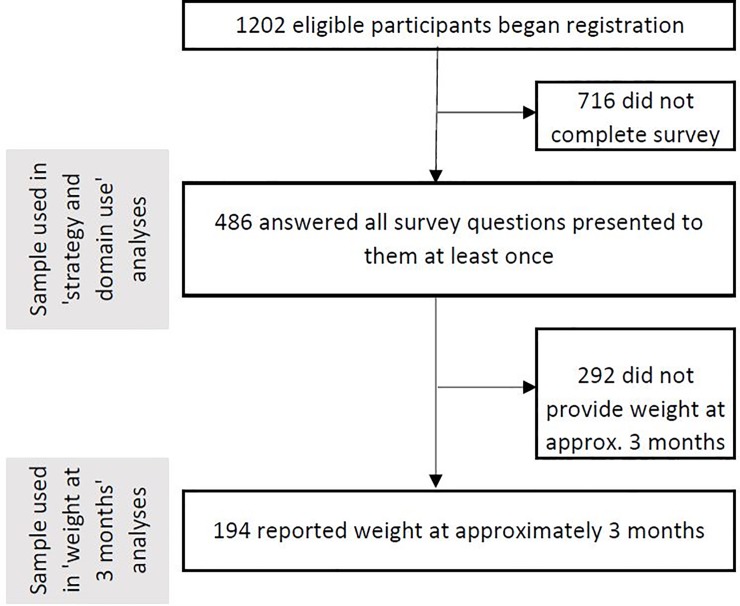
Diagram of study flow.